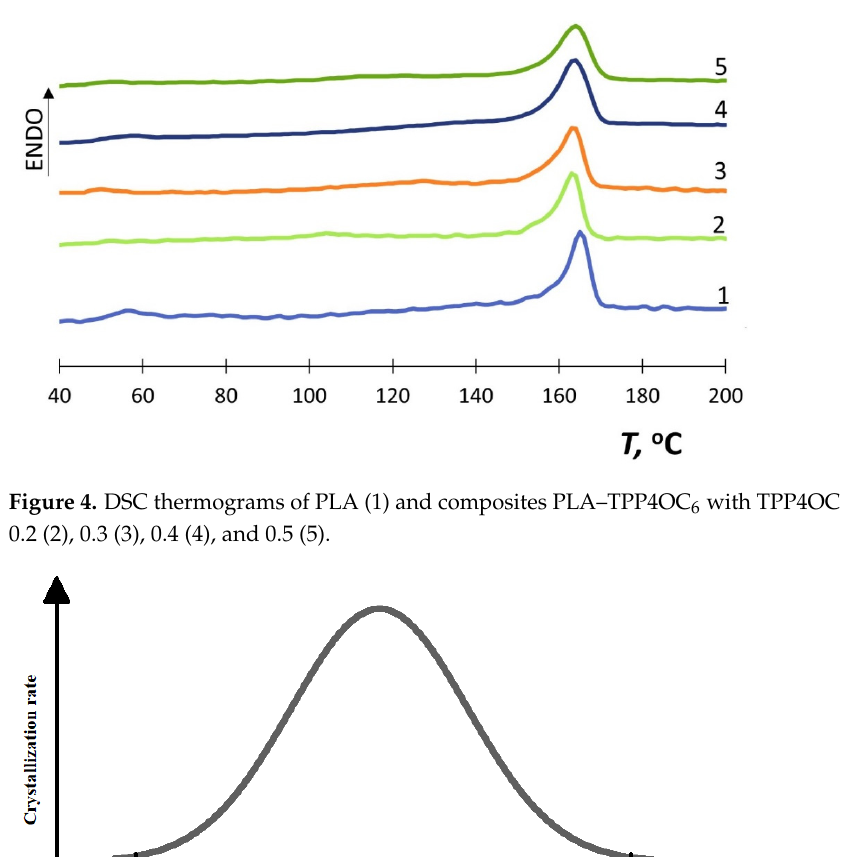
Figure 4. DSC thermograms of PLA (1) and composites PLA–TPP4OC 6 with TPP4OC 6 content, wt.%: 0.2 (2), 0.3 (3), 0.4 (4), and 0.5 (5).